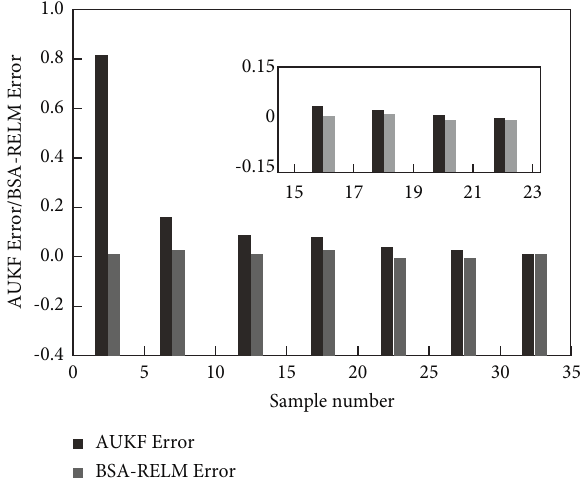
Figure 15: Estimation error of the AUKF algorithm and the Kalman signal big data